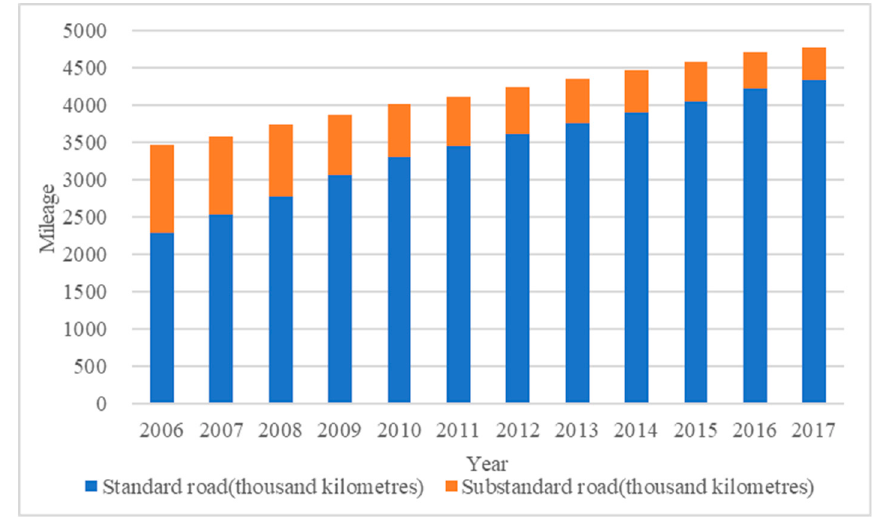
Figure 1. The Development of China’s Roads, 2006 to